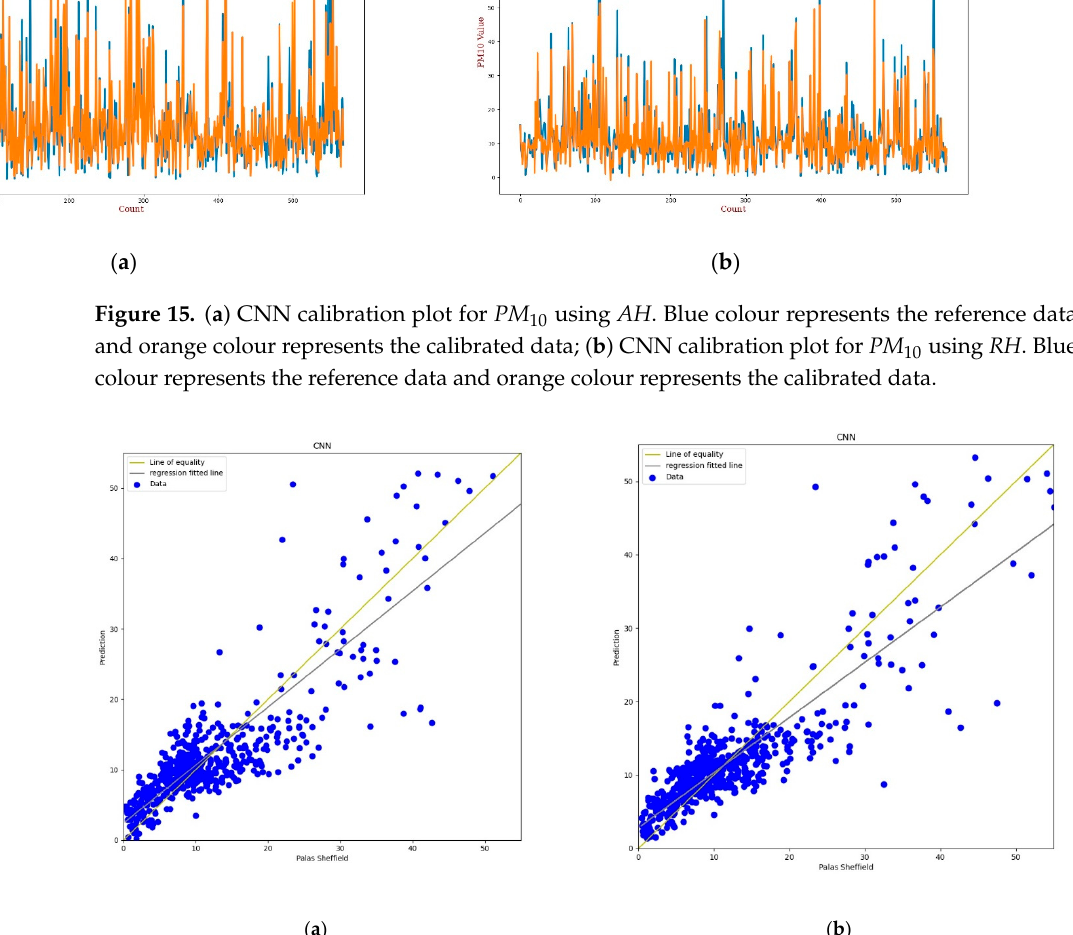
Figure 16. (a) CNN calibration scatter plot for PM 10 with the line of equality, regression fitted line, and the calibrated data using AH ; (b) CNN calibration scatter plot for PM 10 with the line of equality, regression fitted line, and the calibrated data using RH .